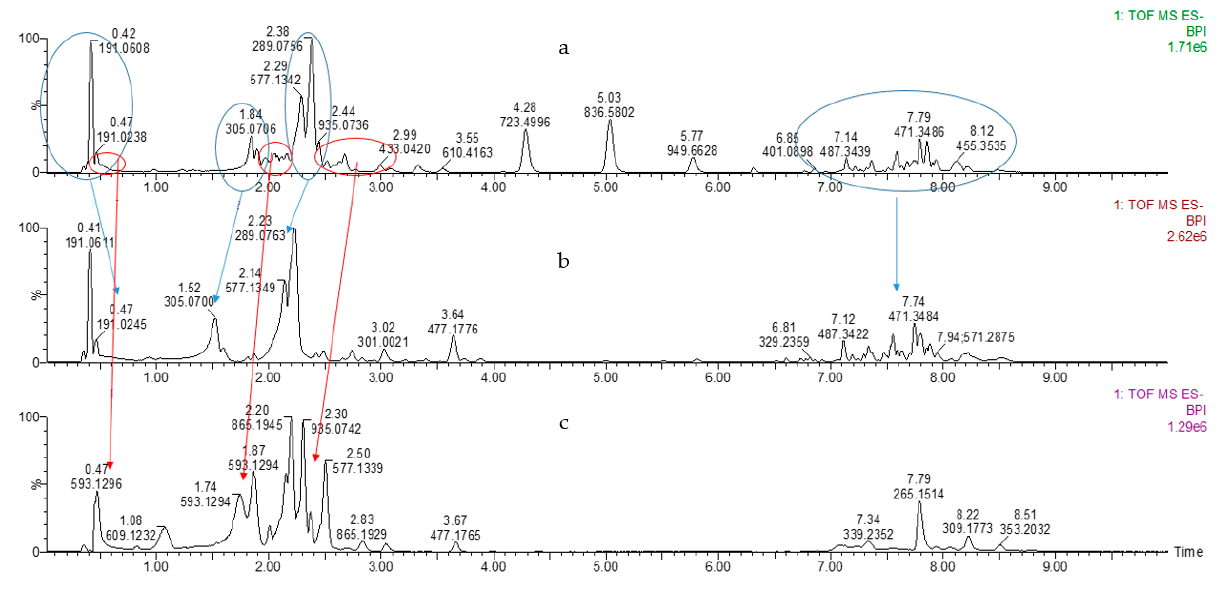
Figure 9. UHPLC-ELS chromatograms: ( a )—50% EtOH extract of ‘Maria Bruvele’ biomass; ( b )—low molecular compound rich fraction; ( c )—procyanidin trimer rich fraction.